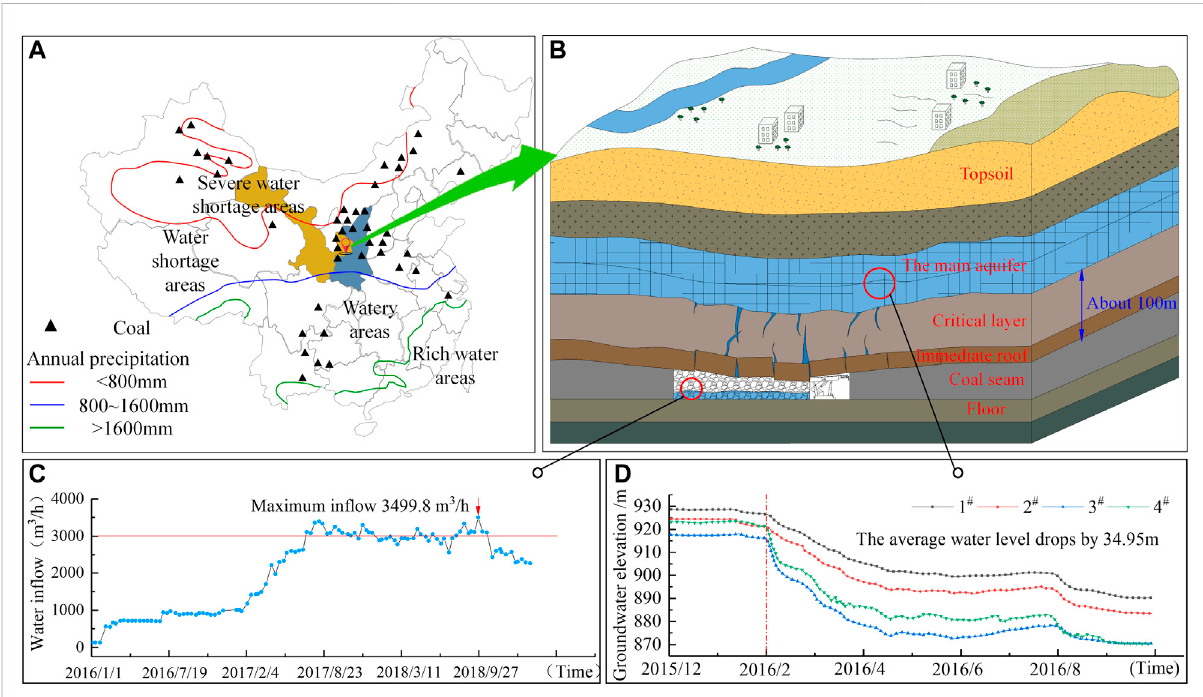
FIGURE 1 Basic information of the mine, (A) China coal-water dual resource distribution map, (B) Diagram of coal seam and aquifer assignment, (C) Working surface water gushing curve graph, (D) Water level variation curve of the aquifer in the upper section of the Luohe Formation.